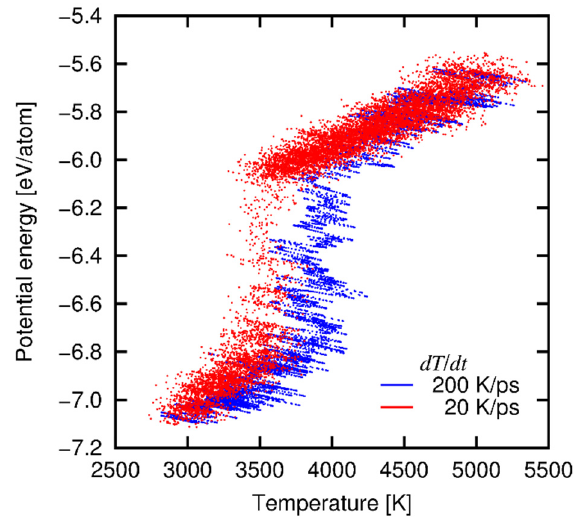
Figure 4. Relationship between potential energy and temperature at heating rates of 20 and 200 K/ps.